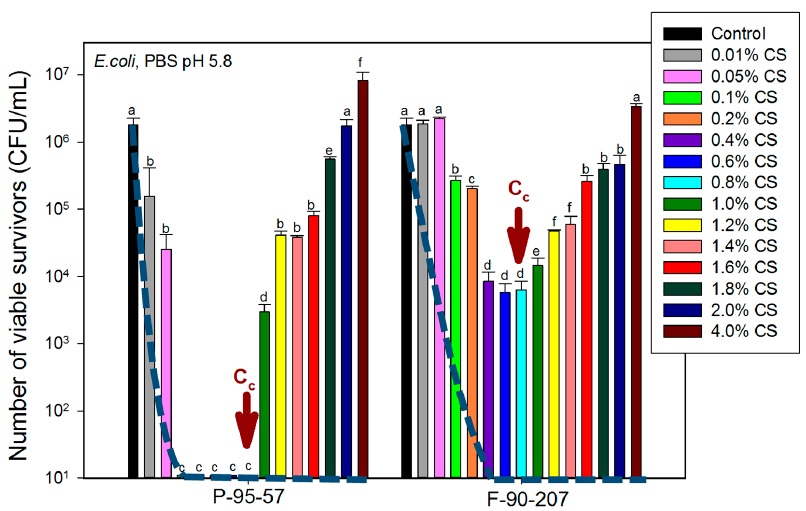
Figure 2. Chitosan in flakes and powder form ( A , C ) and their particle size distribution ( B , D ). The symbols a, b and SSA (in B and D ) represent the average particle size, thickness and the specific surface area, respectively.